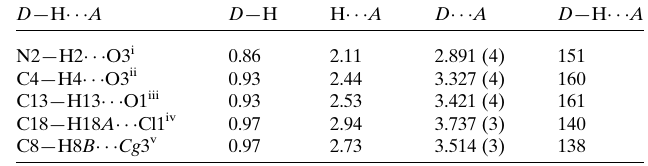
Figure 1 Molecular structure of the title compound showing the atom labelling and displacement ellipsoids drawn at the 50% probability